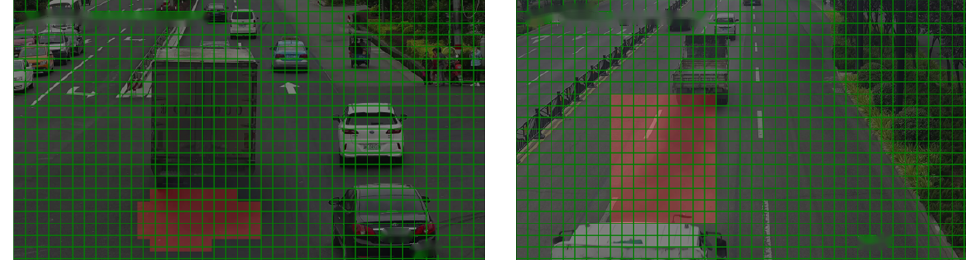
Figure 5. Block-wise annotation converted from PoVSSeg and LaSSoV. Left: Fine-annotated sample. Right: Coarse-annotated